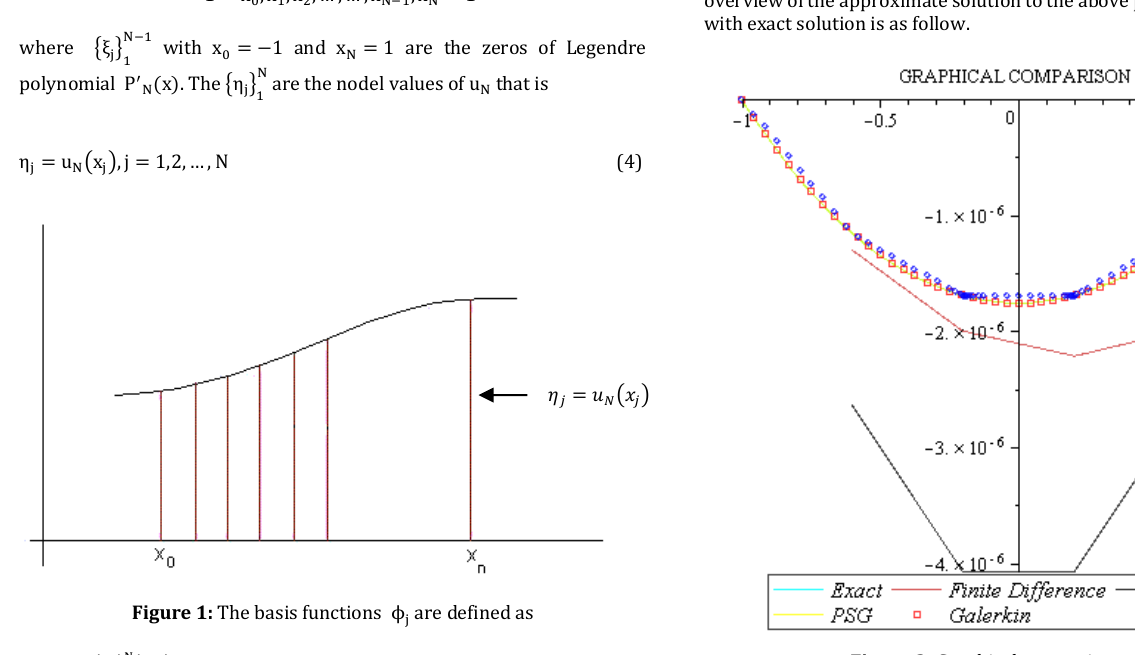
Figure 2: Graphical comparison at N=5